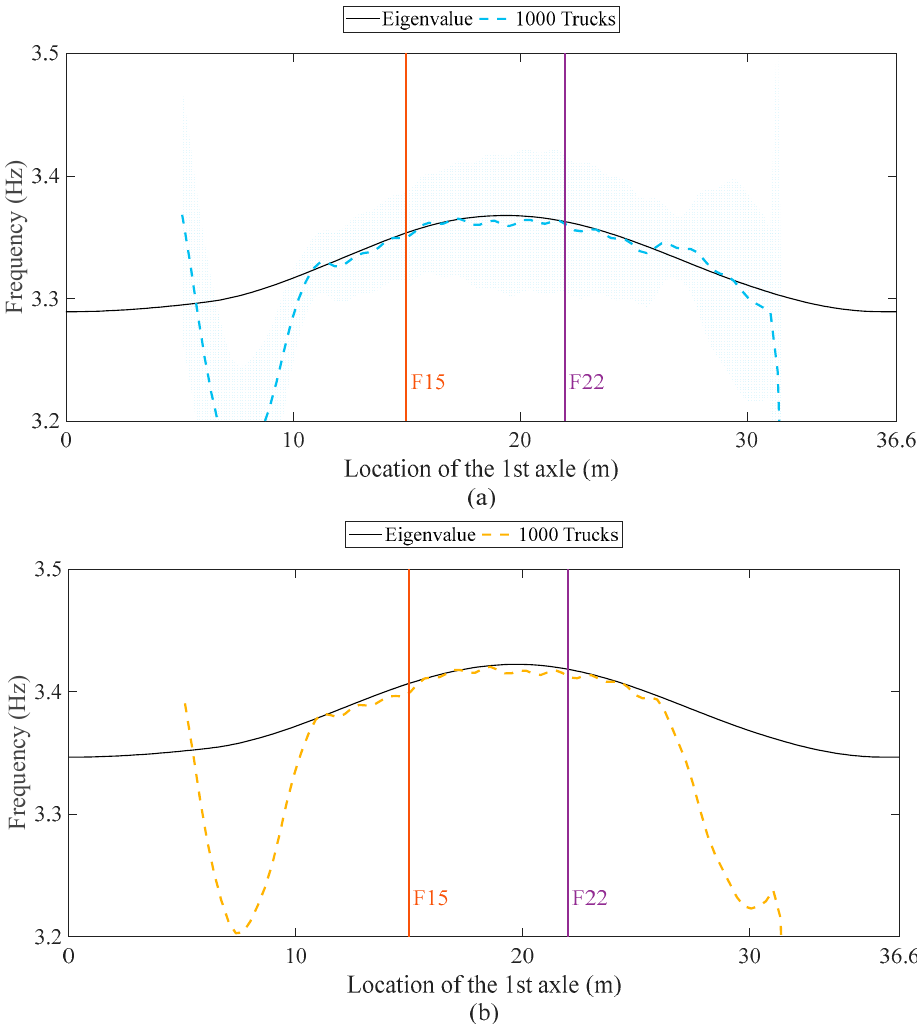
Figure 15. Comparison between transient forced-frequencies due to the crossing of 1000 trucks and eigenfrequencies for scenarios: ( a ) 15% crack at 10 m, and ( b ) 5% crack at 14 m.